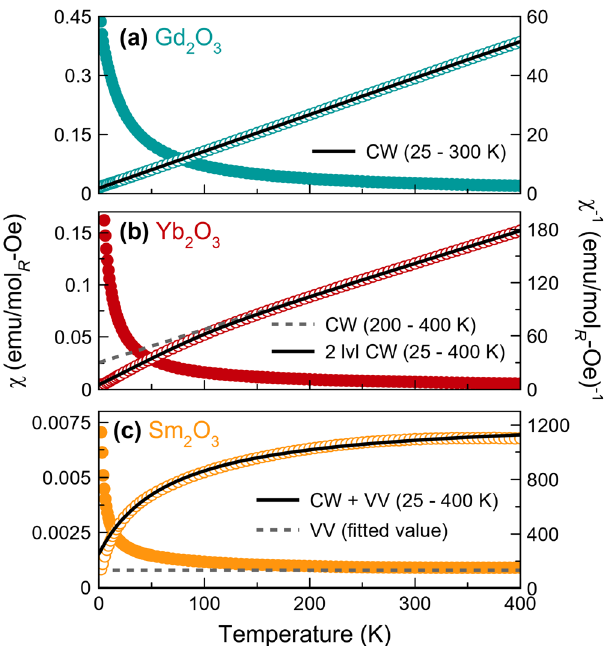
Fig. 5 Representative examples of Curie – Weiss behavior in rare earth magnets. The magnetic susceptibility (left axis, fi lled symbols) and inverse magnetic susceptibility (right axis, open symbols) normalized per mole of rare earth for a Gd 2 O 3 , which is well- fi tted by a standard Curie – Weiss (CW) law, b Yb 2 O 3 , which is well- fi tted by a modi fi ed Curie – Weiss law that incorporates an excited crystal fi eld, and c Sm 2 O 3 , which is well- fi tted by a Curie – Weiss law plus a van Vleck (VV) contribution, all measured in an applied fi eld of H = 1000